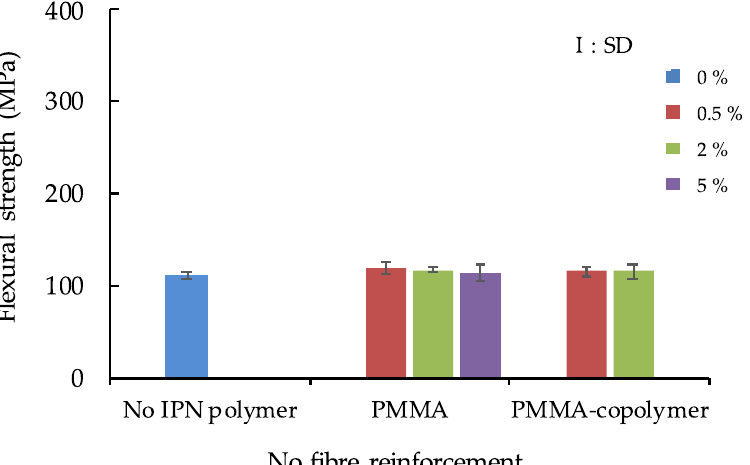
Figure 2. Flexural strength of IPN thermoplastic resin with no fibre reinforcement.